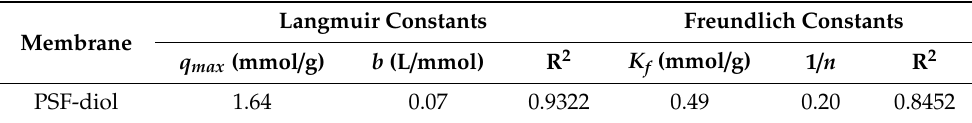
Table 2. List of isotherm parameters for boron adsorption (pH = 8.0, T = 25 °C). Membrane